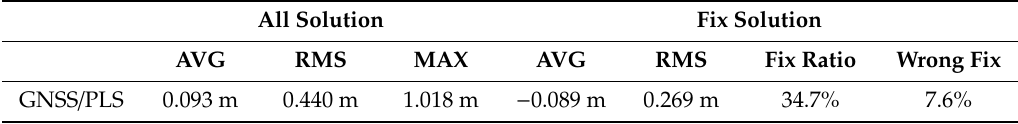
Table 6. GNSS / pseudolite PPP results based on simulation